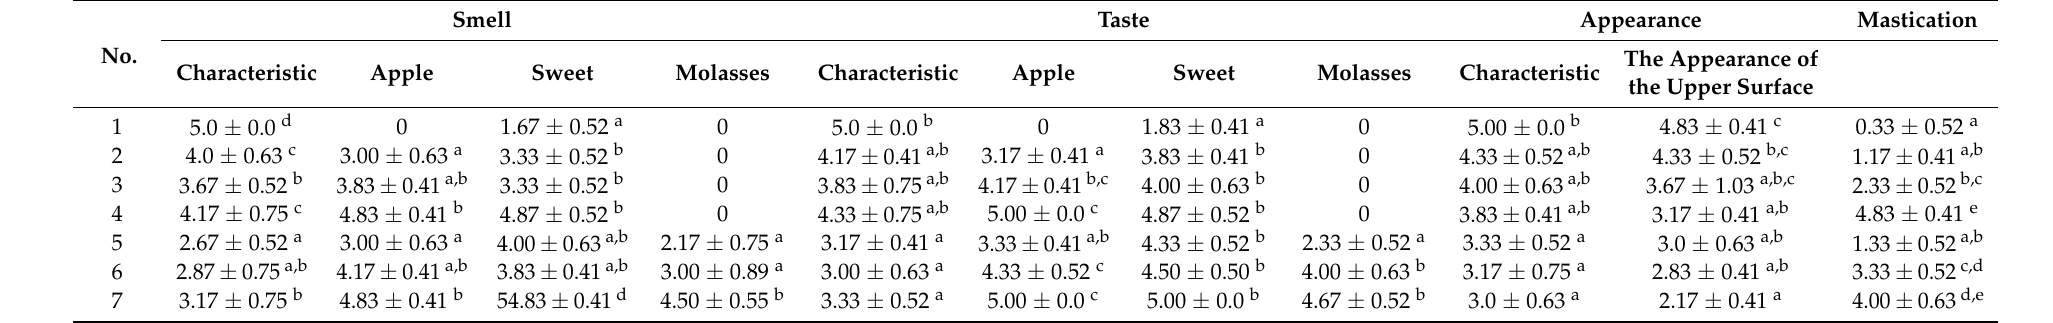
Table 6. Sensory evaluation of the